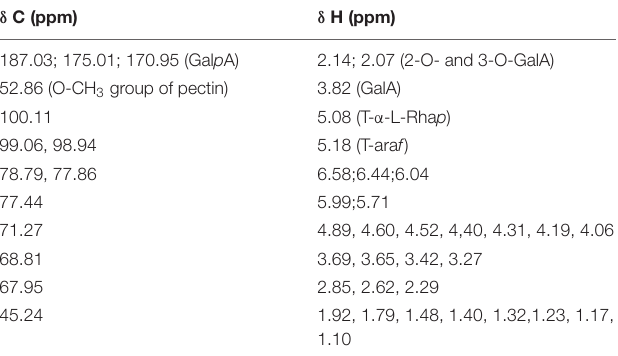
TABLE 1 | The 1 H NMR and 13 C NMR data of LBMP-2 (in D 2 O solvent). δ C